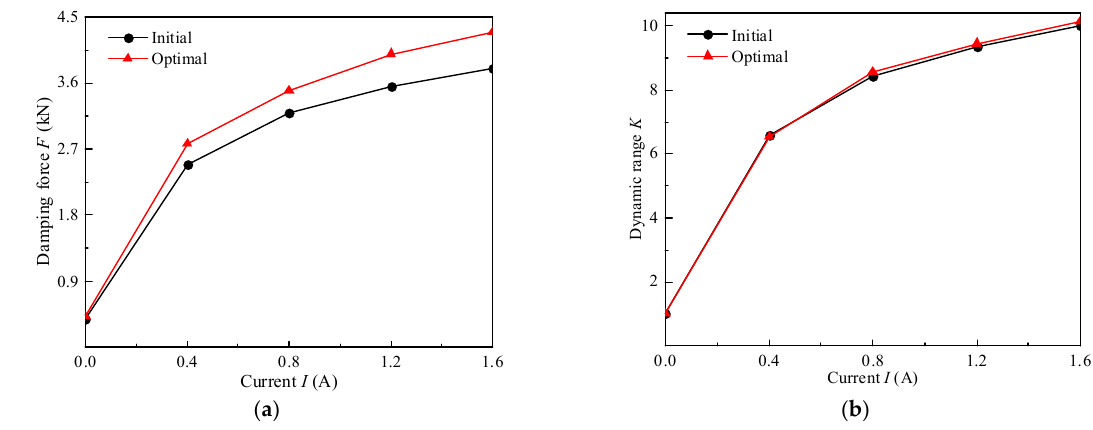
Figure 27. Dynamic performance of the initial and optimal MR valve-control cylinder system at variable currents: ( a ) damping force, ( b ) dynamic range.